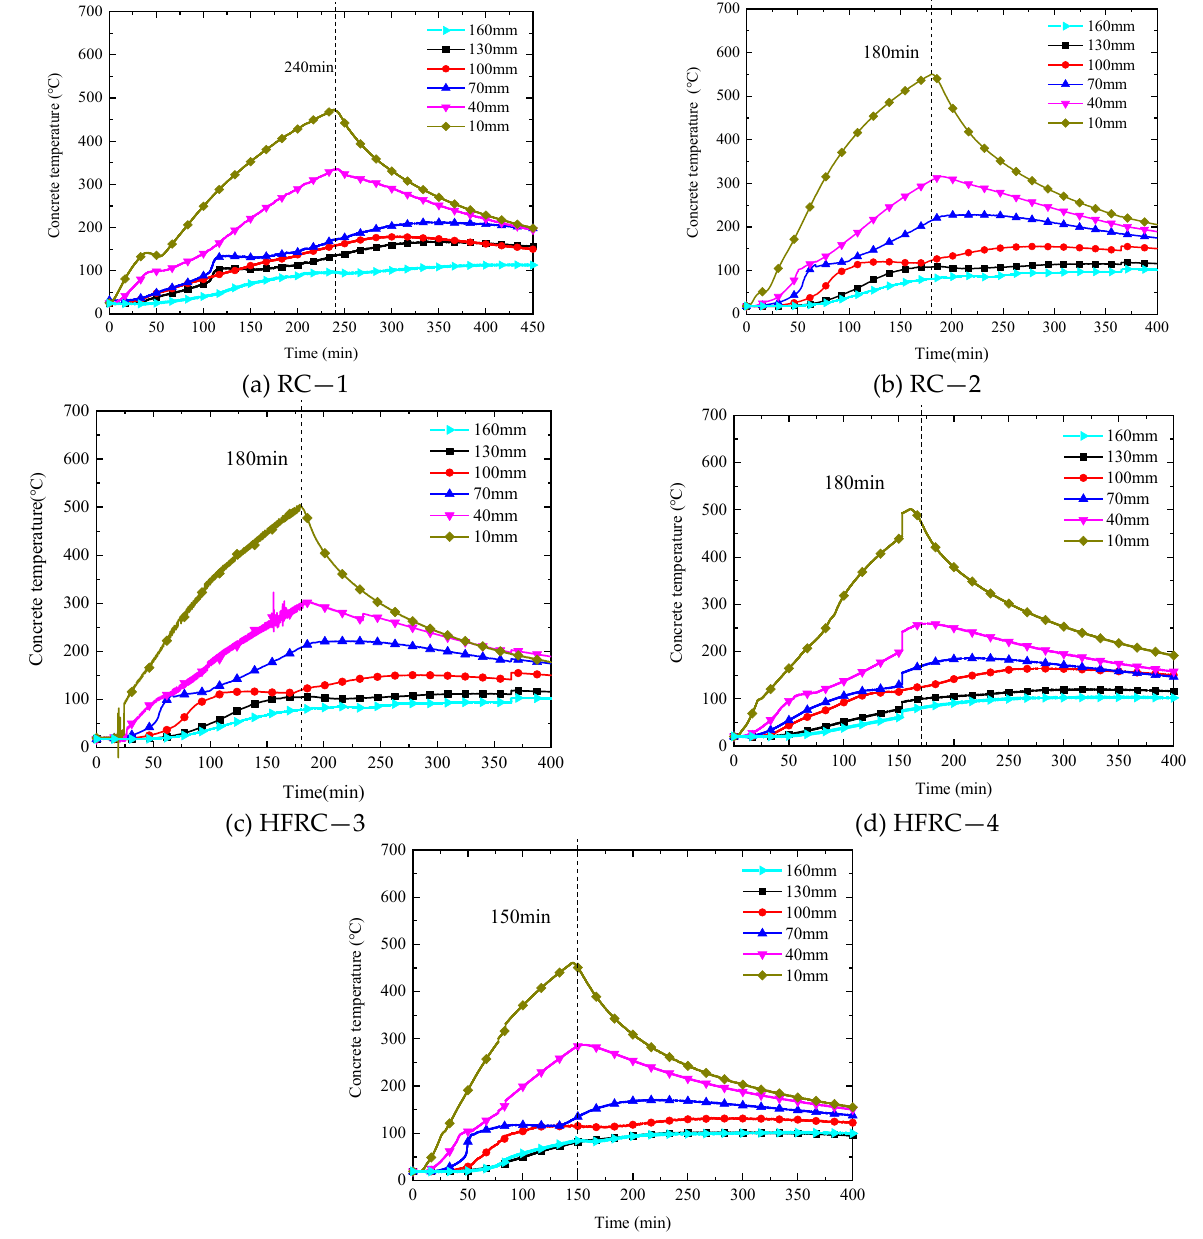
Figure 12. Time–temperature curves of segment sections: ( a ) RC—1; ( b ) RC—2; ( c ) HFRC—3; ( d ) HFRC—4; and ( e ) HFRC—5.